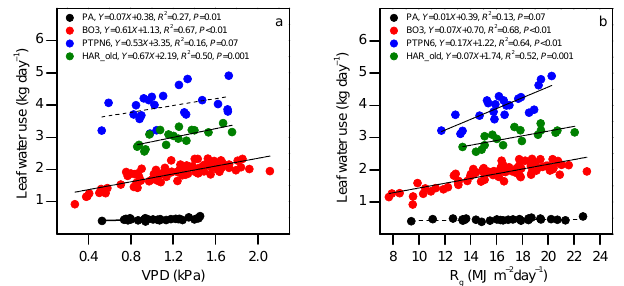
Figure 5. The day-to-day response of leaf water use rates in four different oil palm stands to changes in average daytime vapor pres- sure deficit (VPD) (a) and integrated daily radiation ( R g ) (b) taken from the closest micrometeorological station from the respective plots. Data of at least 20 days per plot, each point represents 1day. Leaf water use rates are from the locations PA (2 years old, black circles), BO3 (12 years old, low water use, red circles), PTPN6 (12 years old, high water use, blue circles) and HAR_old (25 years old, green circles). Significant linear relationships are indicated with solid ( P <0.05) and dotted ( P <0.1) lines, regression functions are provided in the